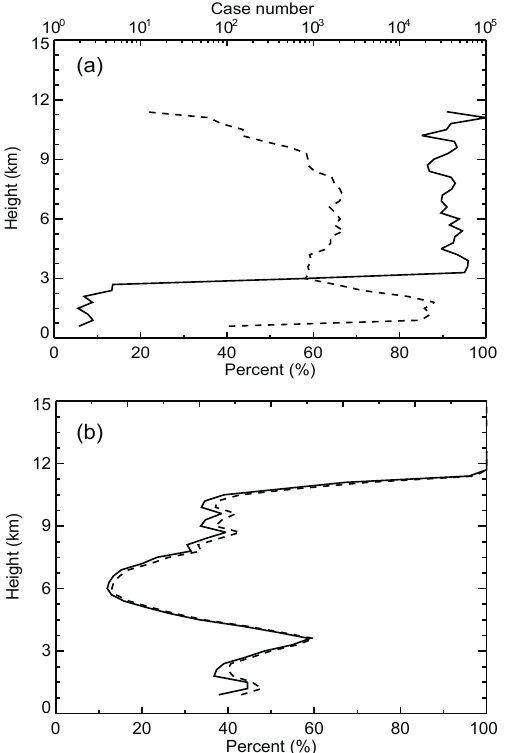
Figure 9. (a) A comparison of the increased detections with the MPL observations. (b) The percentage of the cloud pixels identified by MPL but not by KAZR in the total MPL detected cloud pixels. The solid line in Fig. 9a is the percentage of increased detections seen by both KAZR with our method and MPL as compared with the total increased detections. The dash line in Fig. 9a is the number of increased detections. The solid lines in Fig. 9b represents for the algorithm with noise reduction step. The dash line in Fig. 9b is for the method without noise reduction scheme.